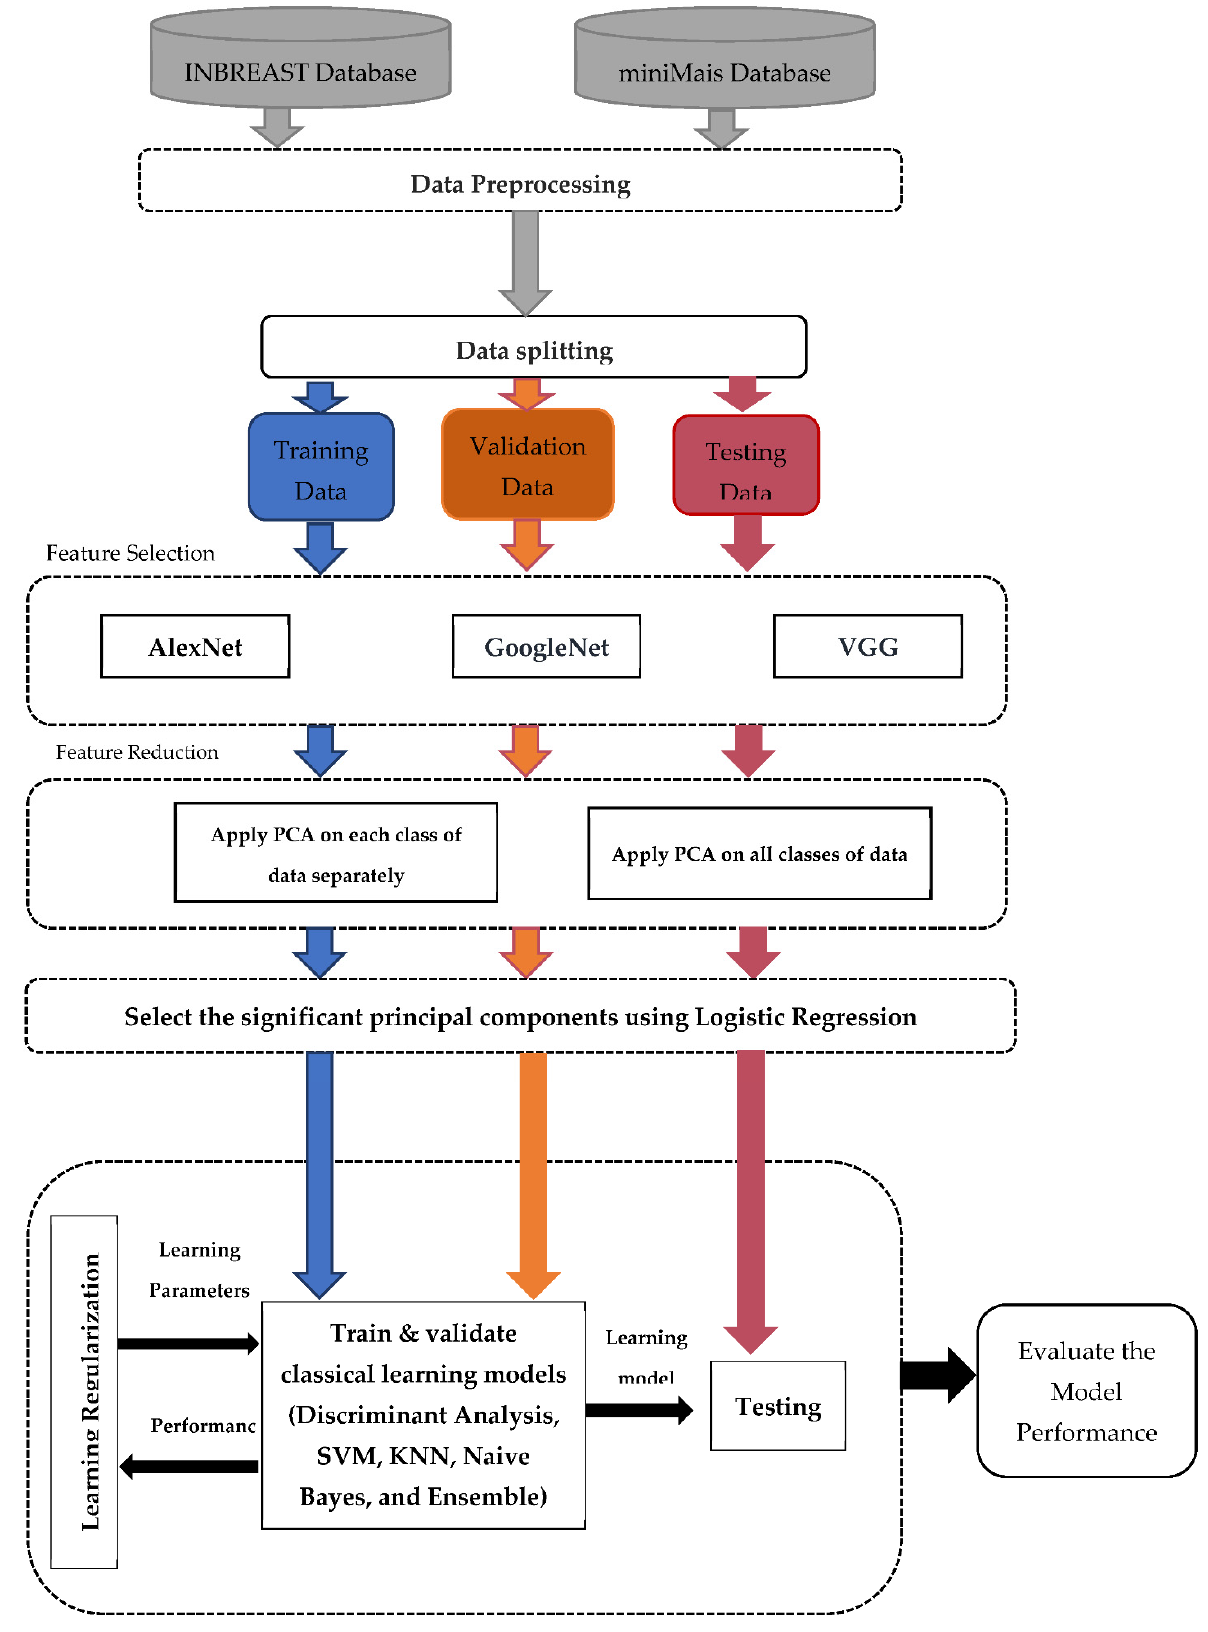
Figure 1. The Proposed CAD framework for breast lesion classification from X-ray mammograms.